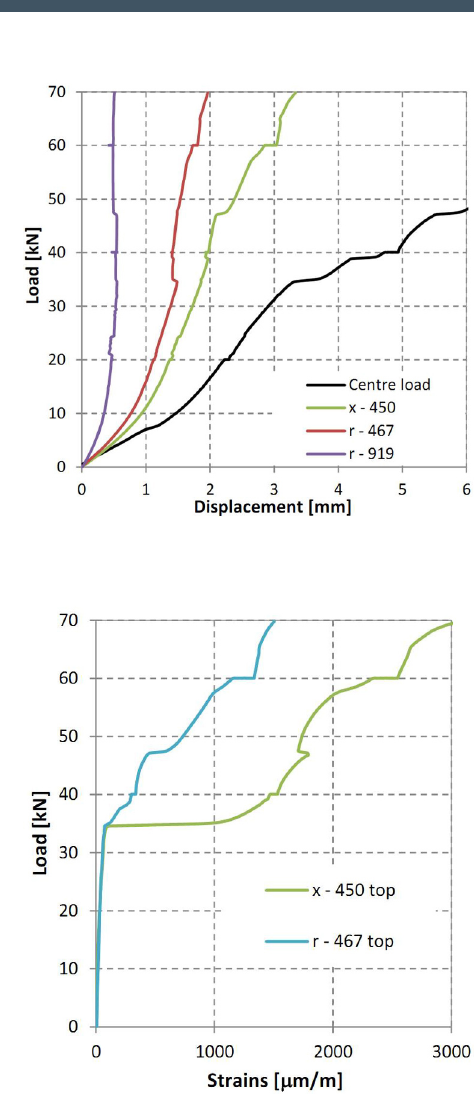
Figure 13. Corner load, (a) Displacements, (b)